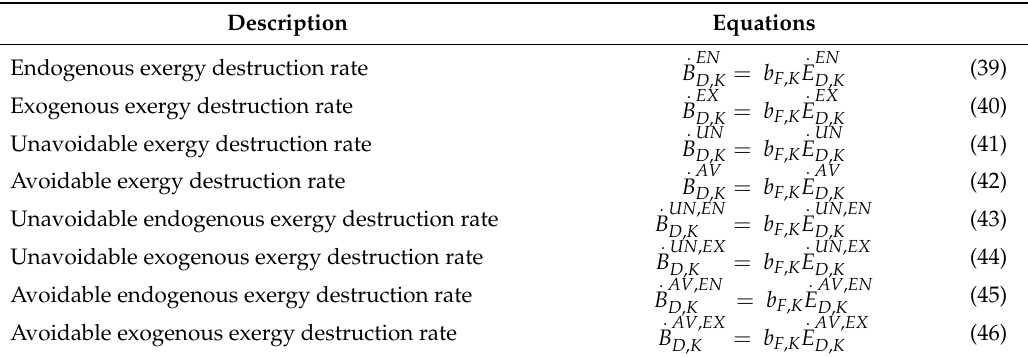
Equations for the advanced exergo-environmental analysis of the proposed system, Cheng et al. [21], Ochoa et al.